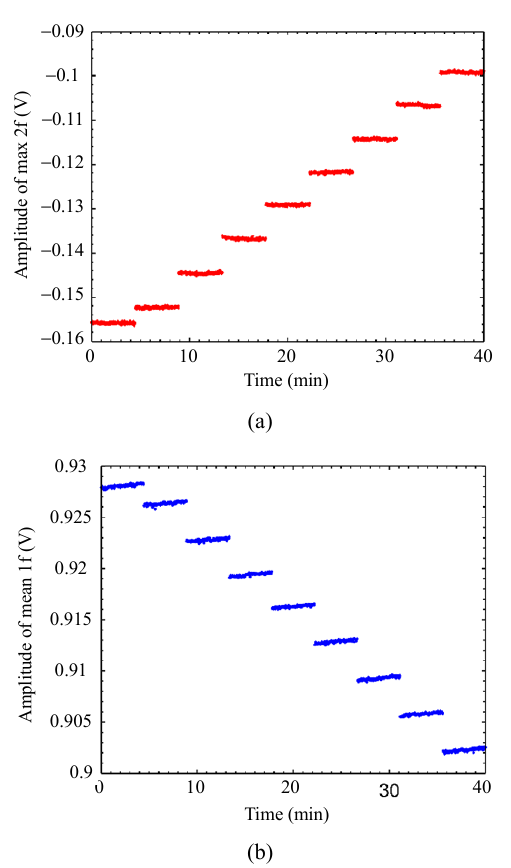
Fig. 4 Measured second and first harmonics versus different concentrations: (a) amplitude of max second harmonic (2f) and (b) amplitude of mean first harmonic (1f) versus measurement time for 0 ppm, 0.2 ppm, 0.6 ppm, 1 ppm, 1.4 ppm, 1.8 ppm, 2.2 ppm, 2.6 ppm, and 3 ppm ethanol concentration levels.